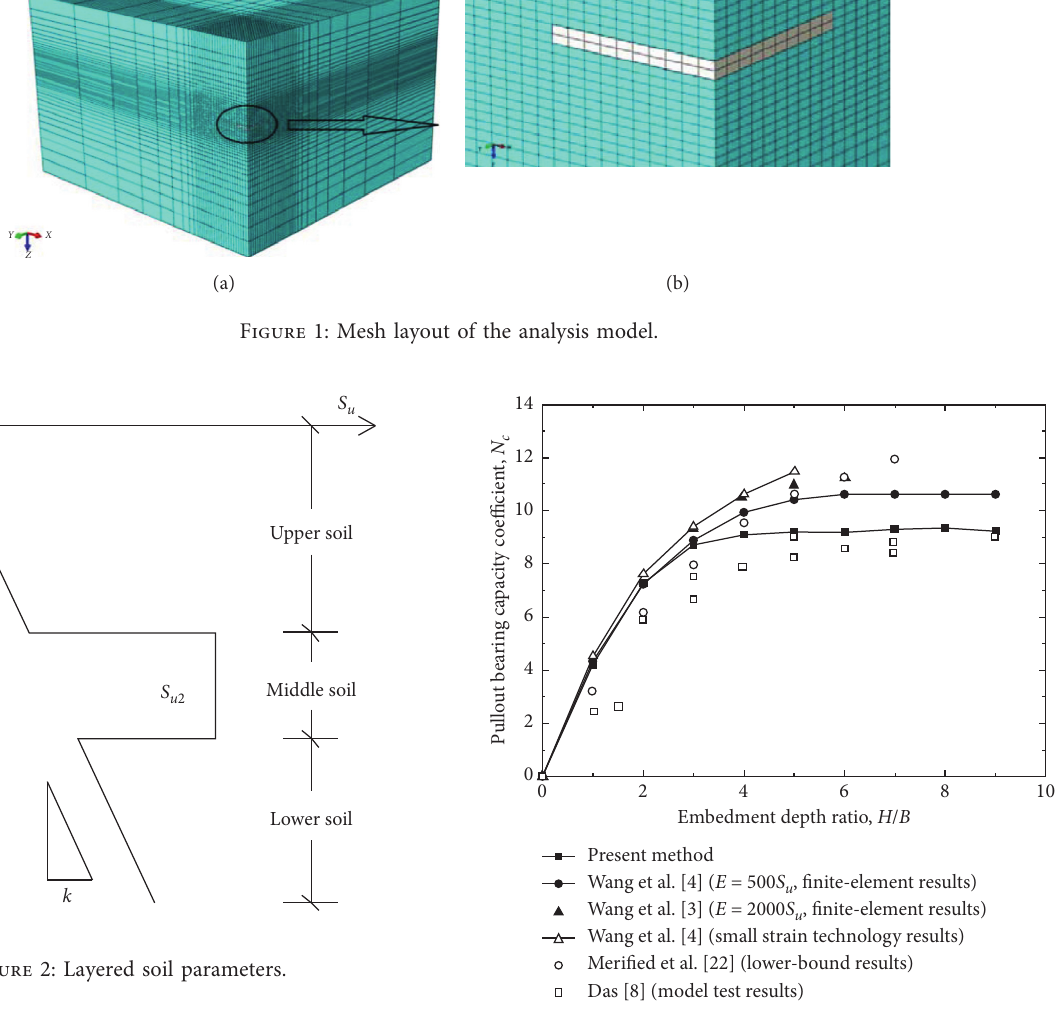
Figure 3: Variation in the pullout bearing capacity coefficient of the plate anchor with the H / B